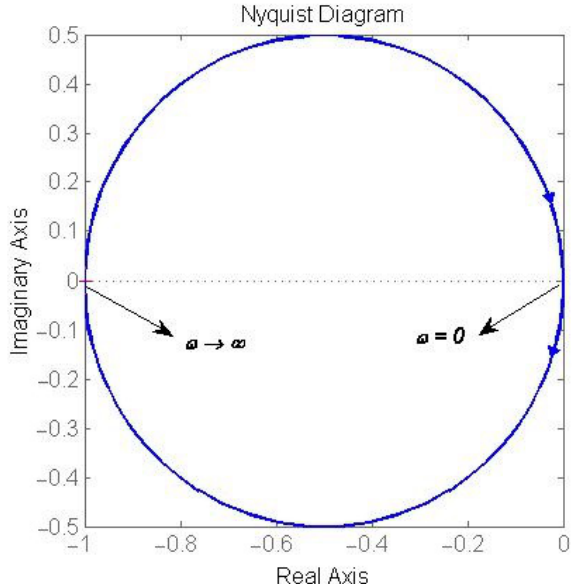
Figure 15. Nyquist plot of H ( s ) .